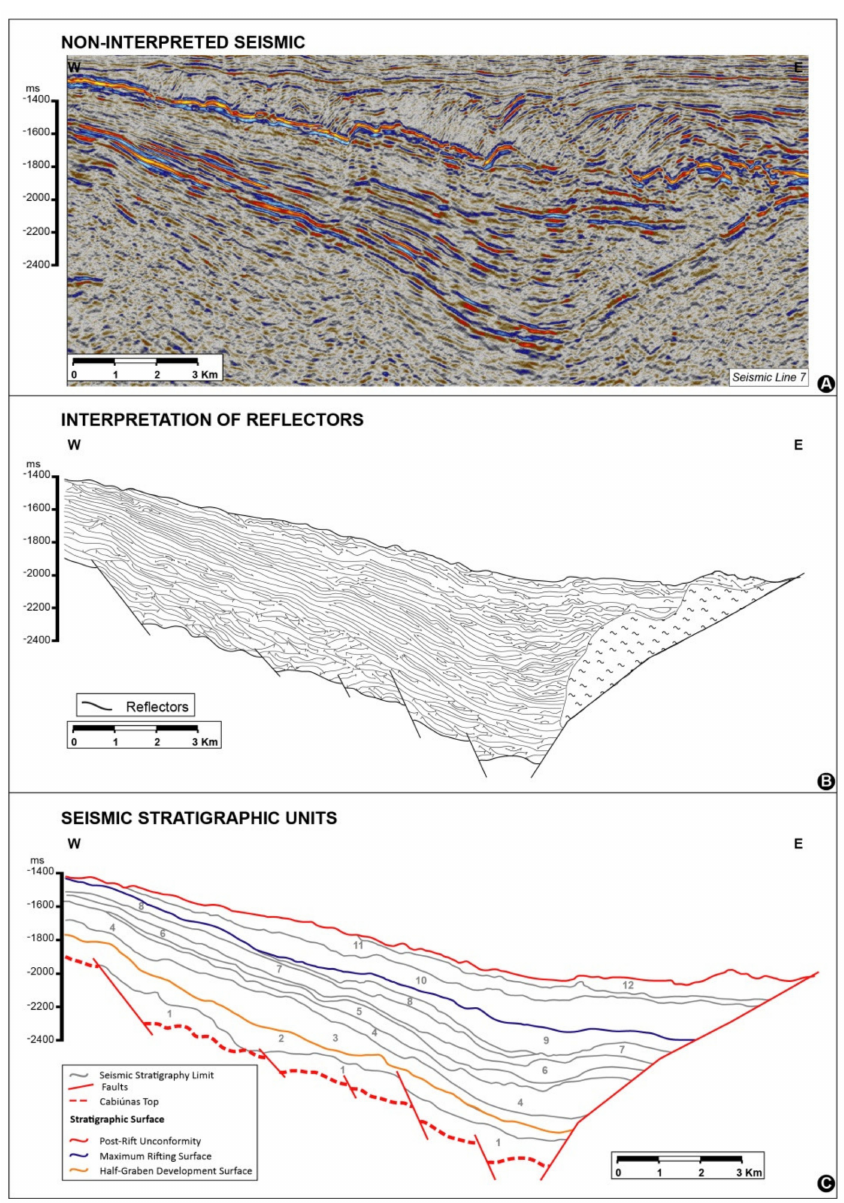
Figure 5. Seismic line L3 (Figure 1B) ( A ) in normal phase without interpretation, ( B ) with reflectors interpretation and ( C ) with interpretation of seismic stratigraphic